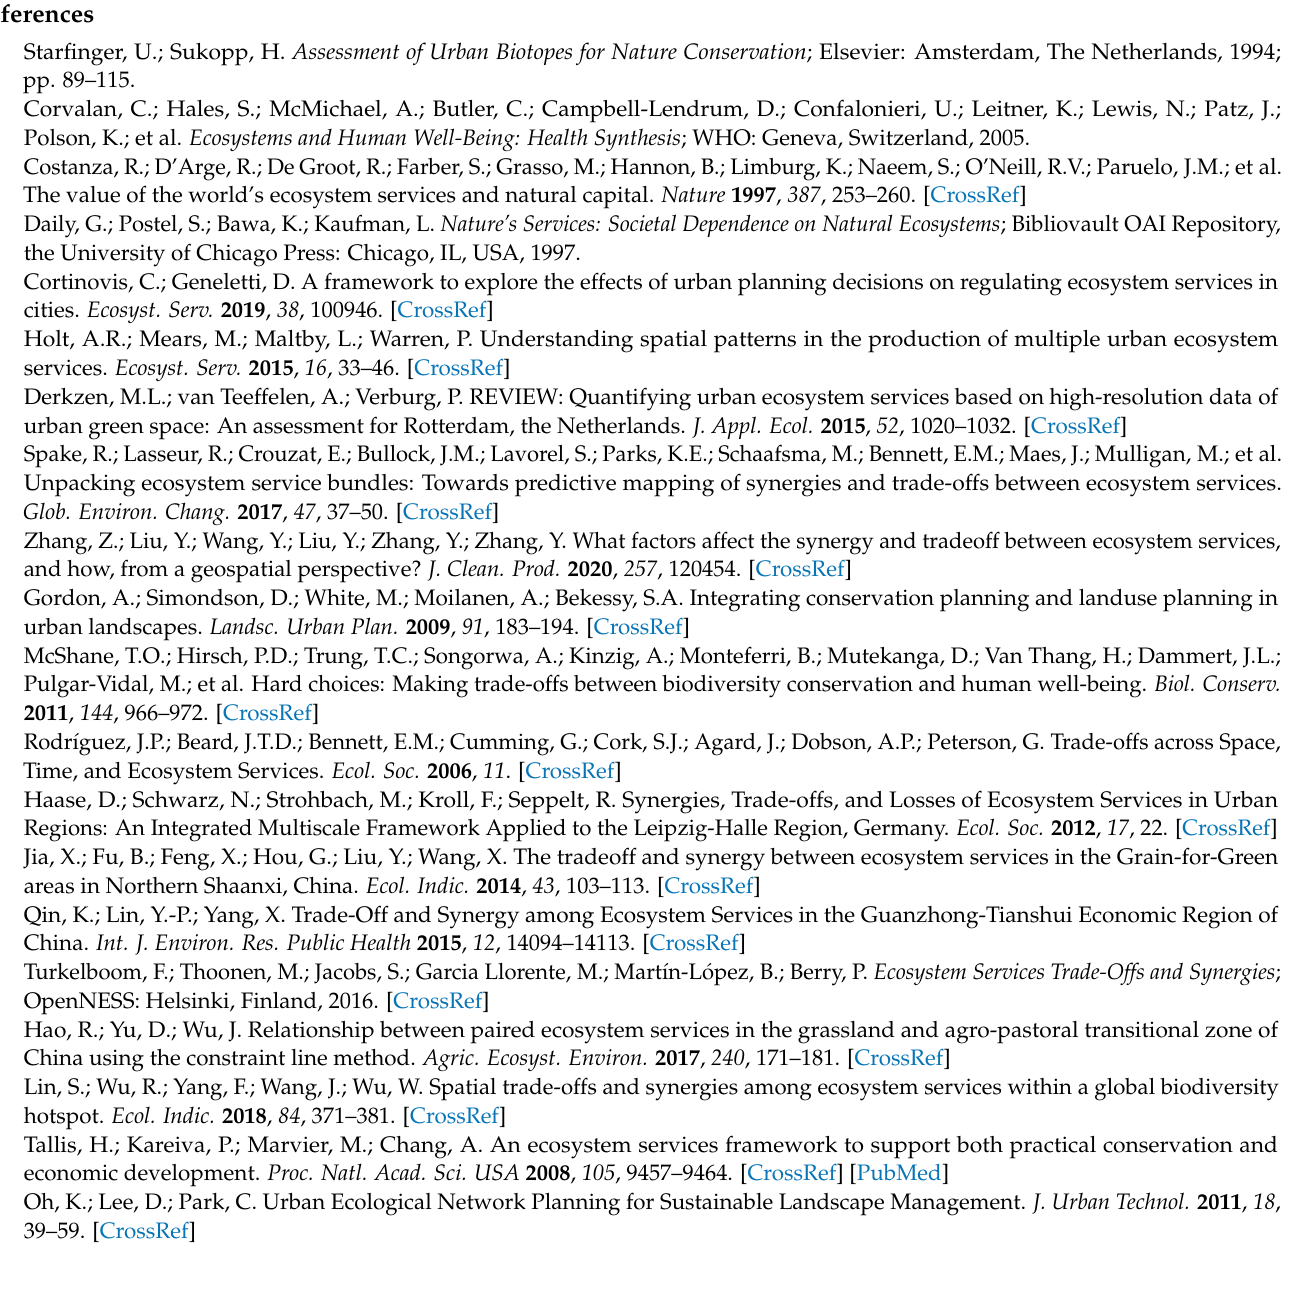
Table A7. Cont . x -axis: 100-CN– y -axis: evapotranspiration